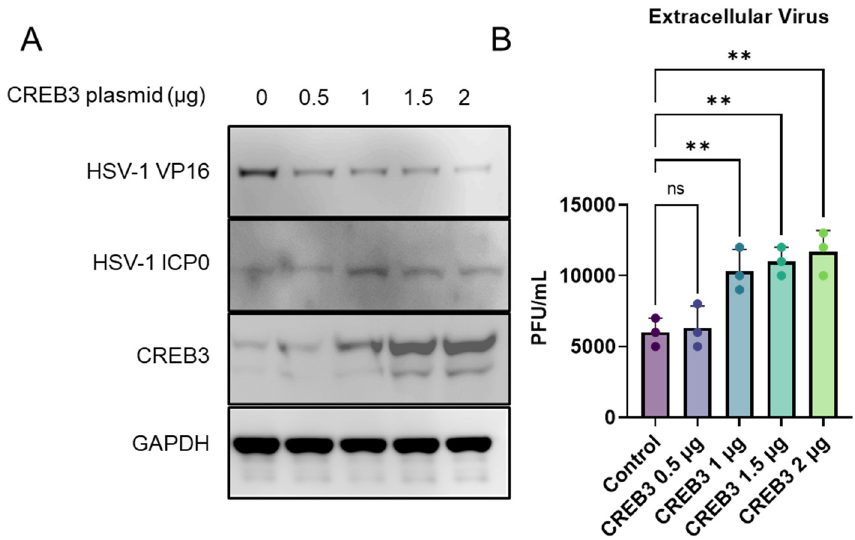
Figure 1. Upregulation of CREB3 causes an increase in extracellular virus: Human corneal epithelial cells were transfected with a control plasmid or increasing concentrations of CREB3 plasmid for 24 h followed by infection with HSV-1 at 0.1 MOI. At 24 h post infection, samples were collected for analysis. ( A ) Representative immunoblot images confirming the upregulation of CREB3 protein with increasing plasmid concentrations ( B ) Cellular supernatants were collected and centrifuged to remove any cellular components prior to overlaying on Vero cells to titrate extracellular infectious virion particles. One-way ANOVA was performed between the datasets to determine statistical significance. ** p -value <